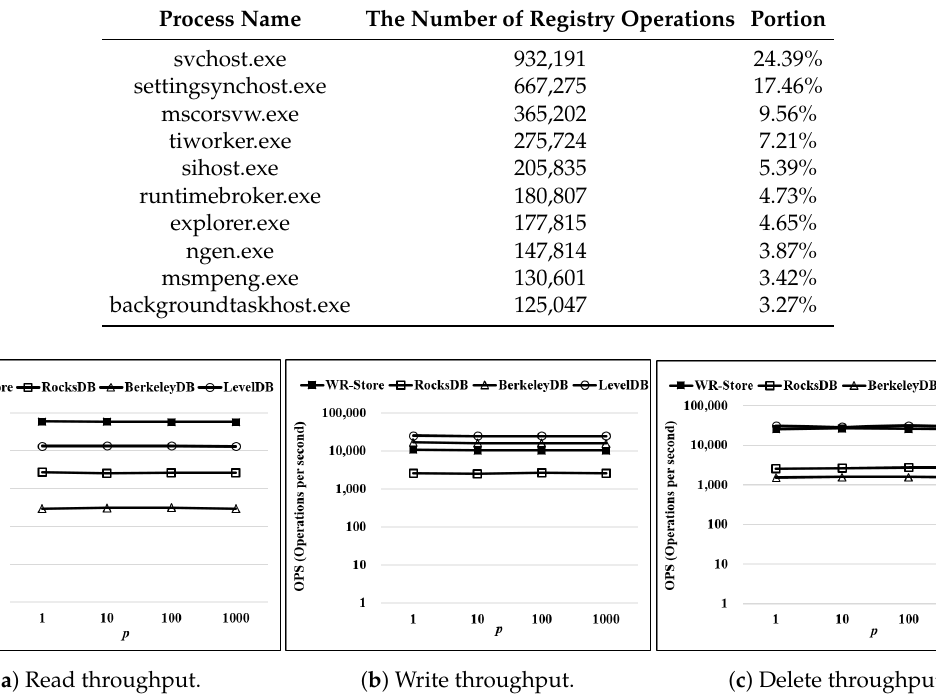
Figure 13. Throughput as the number of concurrently running processes p increases. ( a ) Read throughput; ( b ) Write throughput; ( c ) Delete